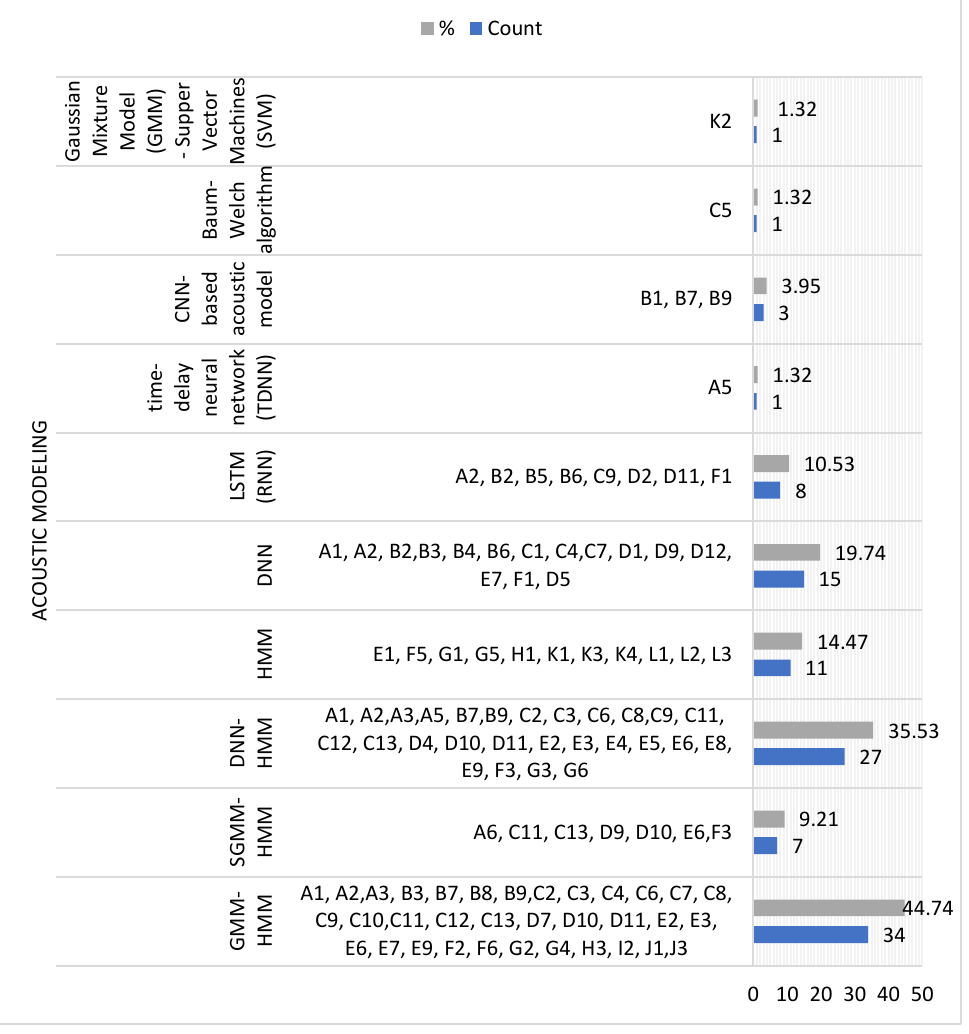
Figure 6. Acoustic models used by the researchers.